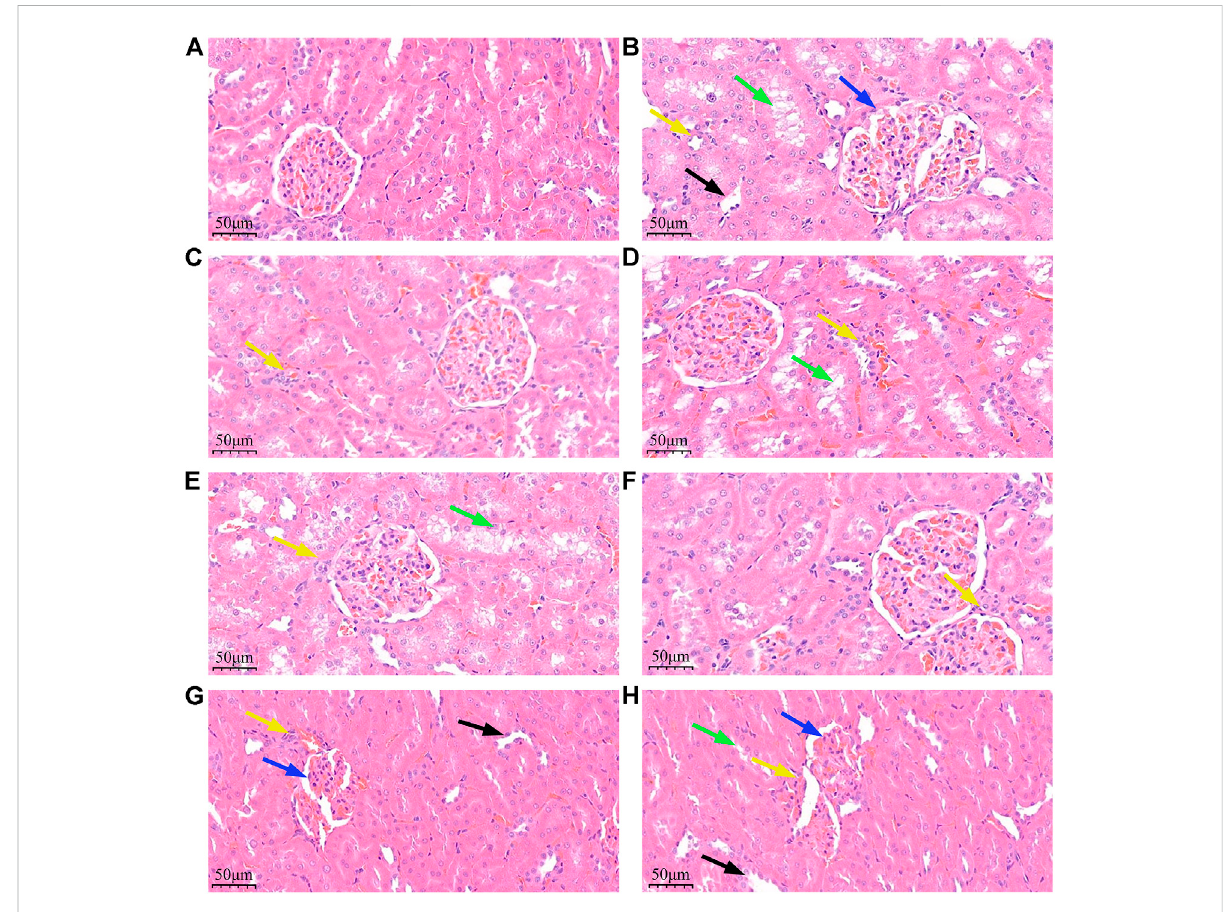
FIGURE 2 Effects of Cornus of fi cinalis and its processed products on renal histopathology in DN rats (HE, ×400). Note: ① (A) . Blank group (B) . DN model group (C) . Irbesartan group (D) . Cornus of fi cinalis group E. Wine Cornus of fi cinalis group (F) . Wine honey Cornus of fi cinalis group (G) . Auxiliary wine group (H) . Auxiliary wine honey group. ② Blue arrows indicate glomerular deformation, black arrows indicate renal interstitial edema, green arrows indicate renal tubular degeneration and atrophy, and yellow arrows indicate interstitial in fl ammatory cell in fi